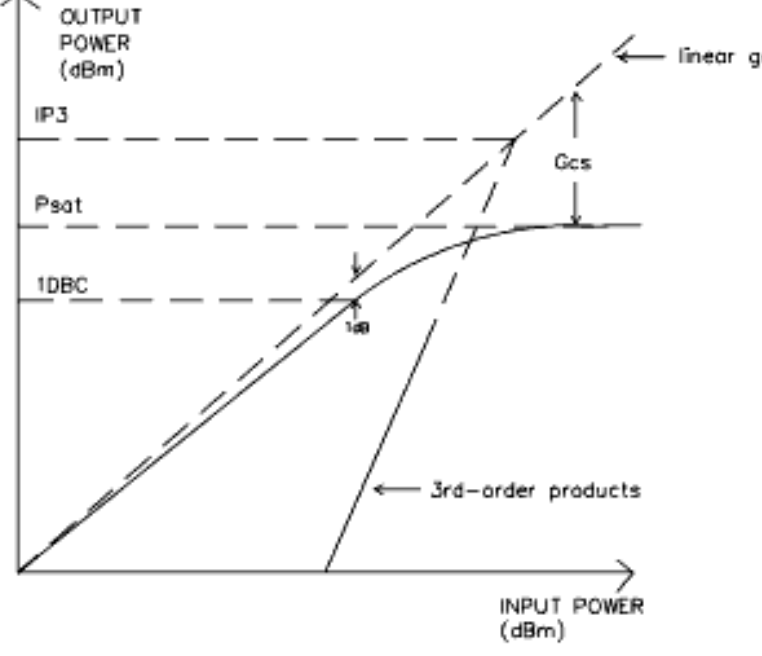
Figure 13. Schematic diagram of nonlinear characteristic index.